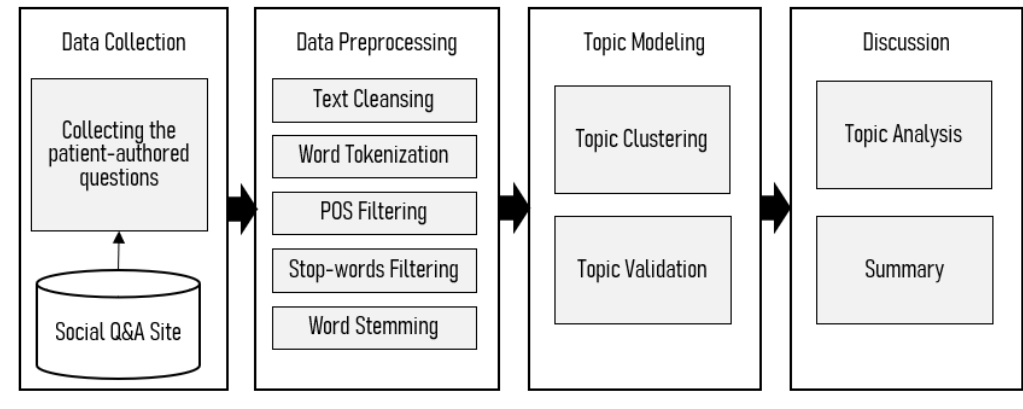
Figure 1. Overall research flow.